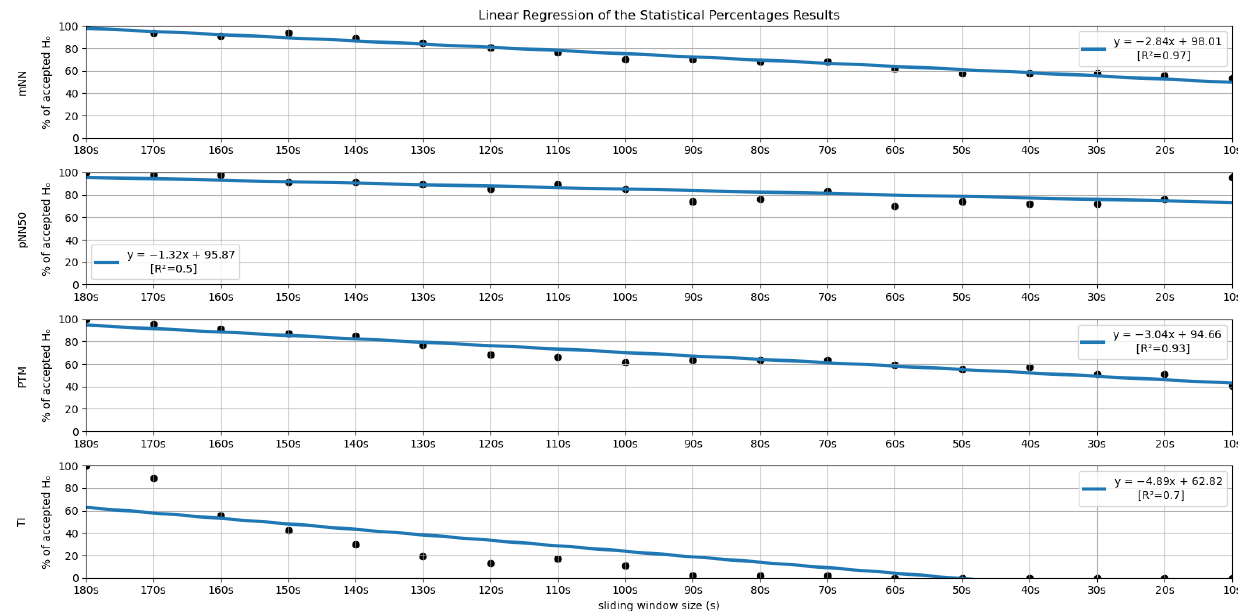
Figure 7. Linear Regressions of the Statistical Percentages obtained for the features mNN, pNN50, PTM and TI.